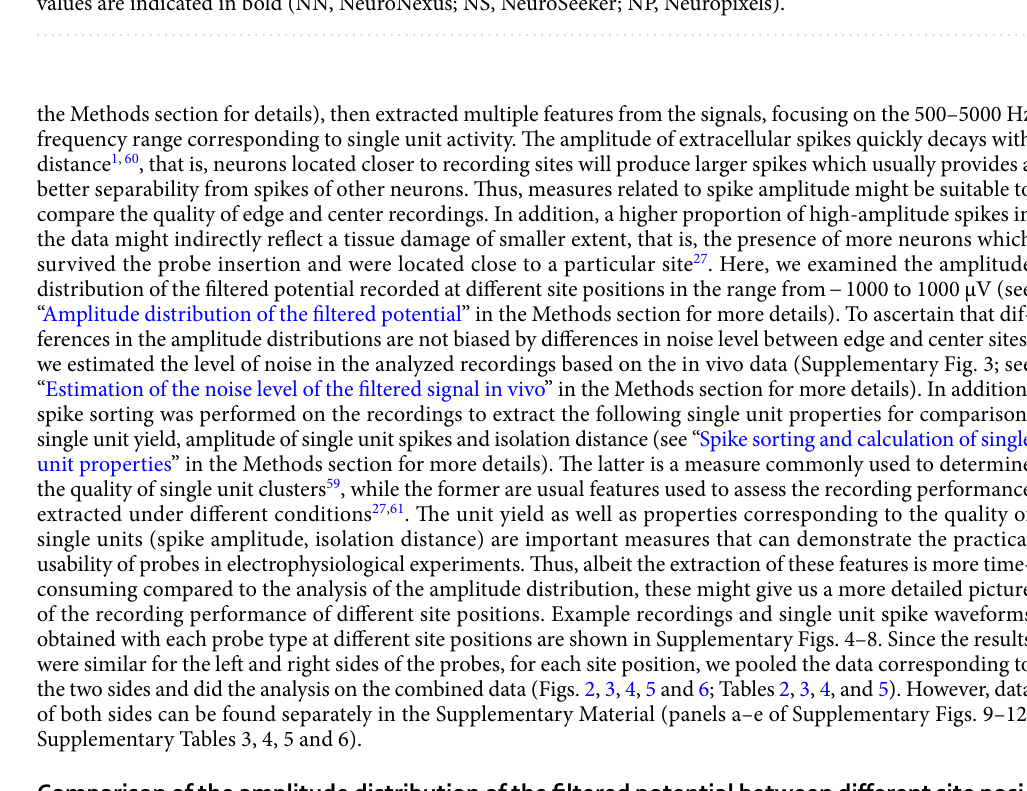
Table 3. Summary of statistical analysis. Brown-Forsythe test was applied to compare the amplitude distributions, while Mann–Whitney U test was used in the case of the last four features. Significant (p < 0.05) values are indicated in bold (NN, NeuroNexus; NS, NeuroSeeker; NP,